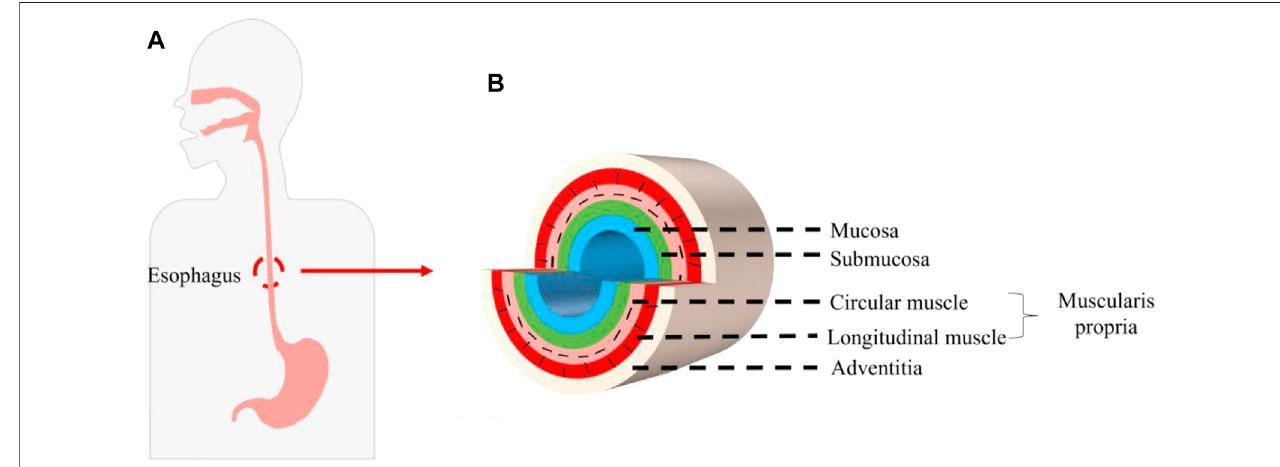
FIGURE 1 | Structure of the human esophagus. (A) Position of the esophagus in the human body. (B) Schematic diagram of cross section of the